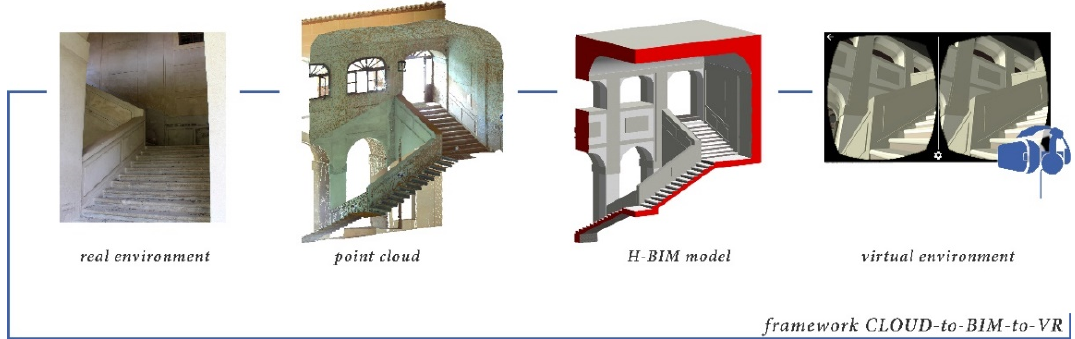
Figure 1: From reality to virtual reality: project framework applied to the Simón Ruiz